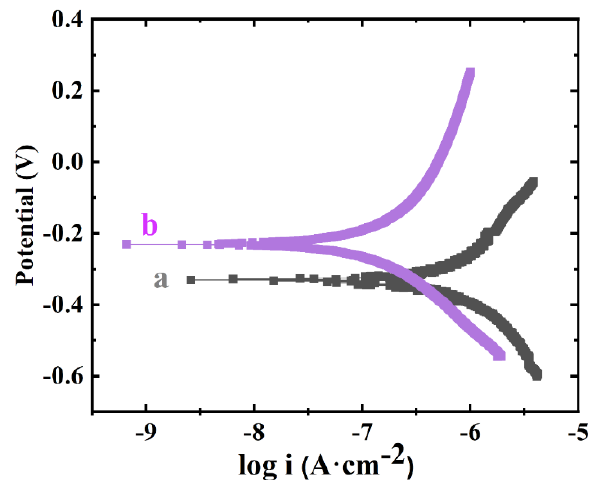
Figure 5. Tafel plots for ( a ) uncoated substrate and ( b ) coated from 5 g L − 1 PVDF suspensions containing 1 g L − 1 GA and annealed at 200 °C. PVDF films were obtained at deposition time of 5 min and deposition voltage of 100 V.